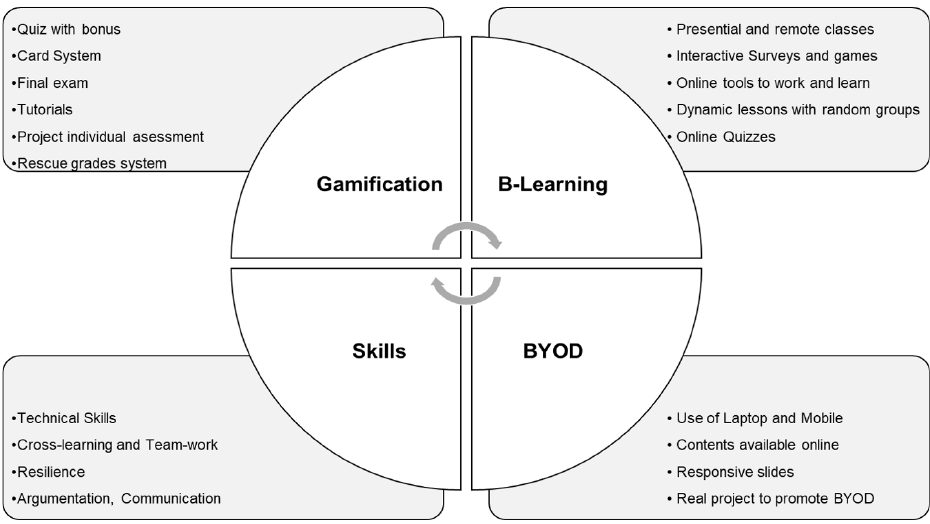
Figure 2. Main concepts of the